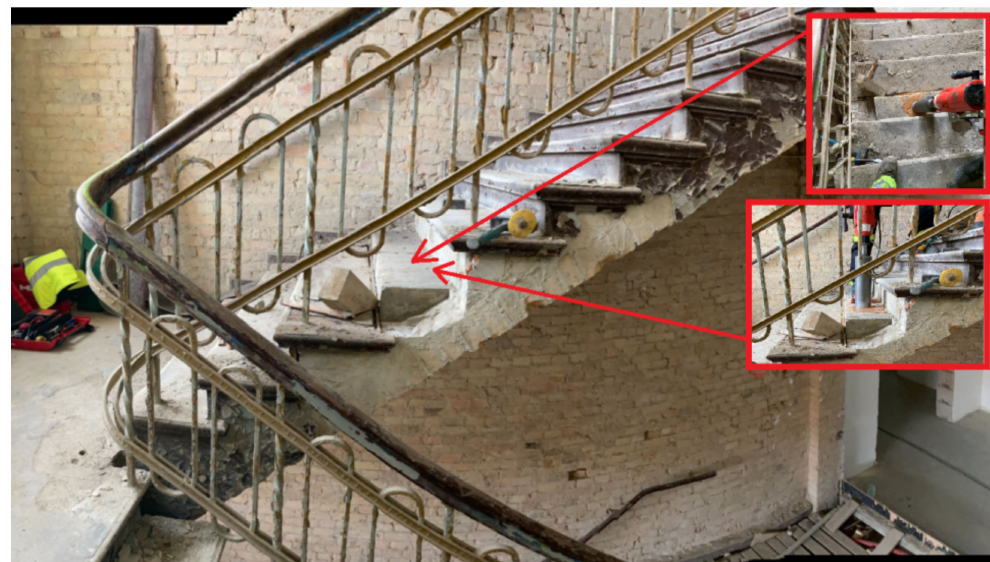
Figure 7. A view of a staircase with sample 1 location. Representative sample No. 2 was taken from the landing (Figure 8). The sample tests were carried out in the Pilot 4 testing machine in accordance with the applicable standards. The obtained results are presented in Table 1.